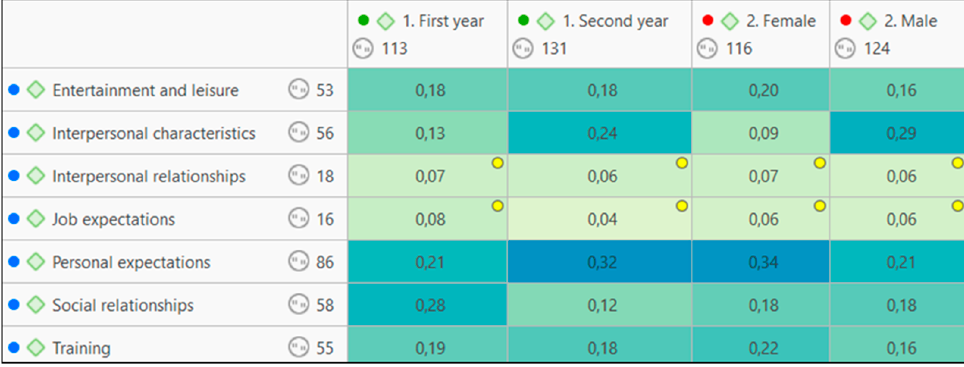
Figure 2. Table of co-occurrences between thematic codes that emerged in the analysis and codes assigned for gender and course on which the student is enrolled. 5